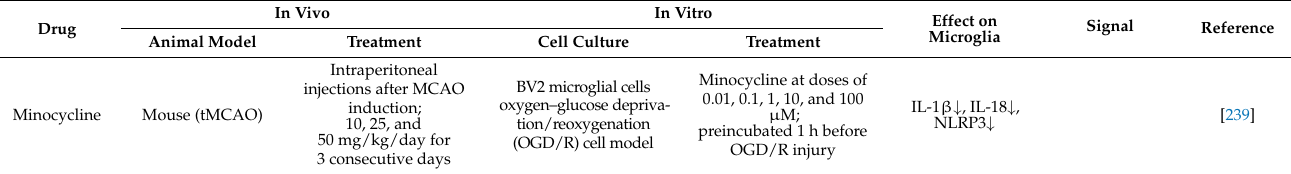
Table 3. Pharmacotherapy can promote post-stroke recovery by targeting microglia. ↑ , upregulate; ↓ , downregulate; Gal-3, galectin-3, MCAO/R, middle cerebral artery occlusion/reperfusion; tMCAO, transient MCAO; dMCAO, distal MCAO; pMCAO, permanent MCAO; PT, photothrombosis; OGD/R, oxygen-glucose deprivation/reperfusion; LPS, lipopolysaccharide; IL-1 β , interleukin-1 β ; IL-18, interleukin-18; NLRP3, NOD-like receptor thermal protein domain associated protein 3; TNF- α , tumor necrosis factor- α ; IL-10, interleukin-10; TGF- β , transforming growth factor- β ; Ym1, chitinase- like protein 3, IL-6, interleukin-6; iNOS, inducible nitric oxide synthase; Arg-1, arginase-1; IFN- γ , interferon- γ ; IL-17, interleukin-17; IL-4, interleukin-4; MCP-1, monocyte chemotactic protein-1; MMP9, matrix metalloproteinase 9; NO, nitric oxide; COX-2, cyclooxygenase-2; STAT1, signal transducer and activator of transcription 1; STAT6, signal transducer and activator of transcription 6; NF- κ B, nuclear factor kappa-B; TLR4, toll-like receptor 4; STAT3, signal transducer and activator of transcription 3; JAK2, Janus kinase